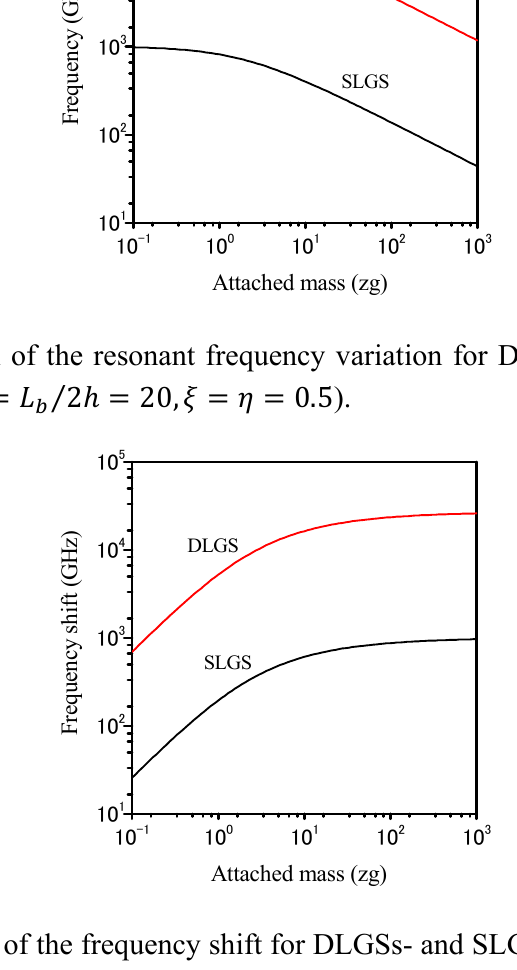
Figure 6. The attached mass is located either at the center ((cid:2022), (cid:2015)) = (0.5, 0.5) of the DLGSs, near to the corner ((cid:2022), (cid:2015)) = (0.25, 0.25) , or near to the edge ((cid:2022), (cid:2015)) = (0.5, 0.25) . It can be found that the